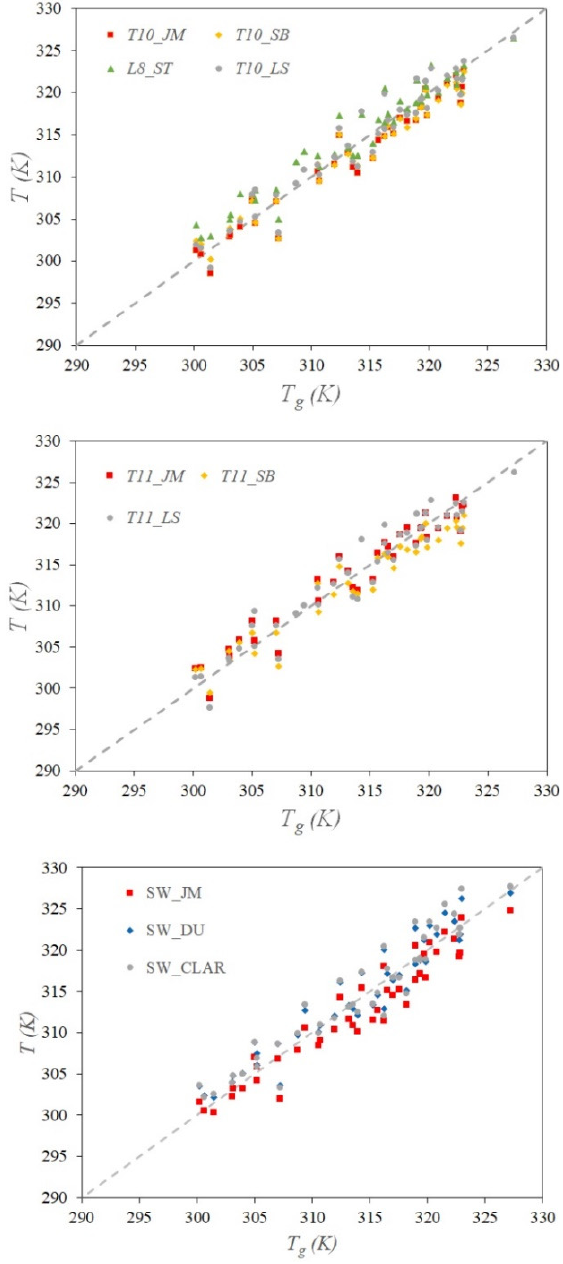
Figure 5. T obtained from all methodologies presented in Section 2 versus ground-measured Temper- ature ( T g ). Same labels for the algorithms as described in Figure 4. Dashed line represents the 1:1 agreement. Error bars are not included for cleanliness. Table 5. Statistics of the differences in terms of LST ( T-T g ) for the different algorithms, filtered by crop type. Same labels for the algorithms as described in Table 4. Number of cases (N) and the ground temperature mean variability are also included for each